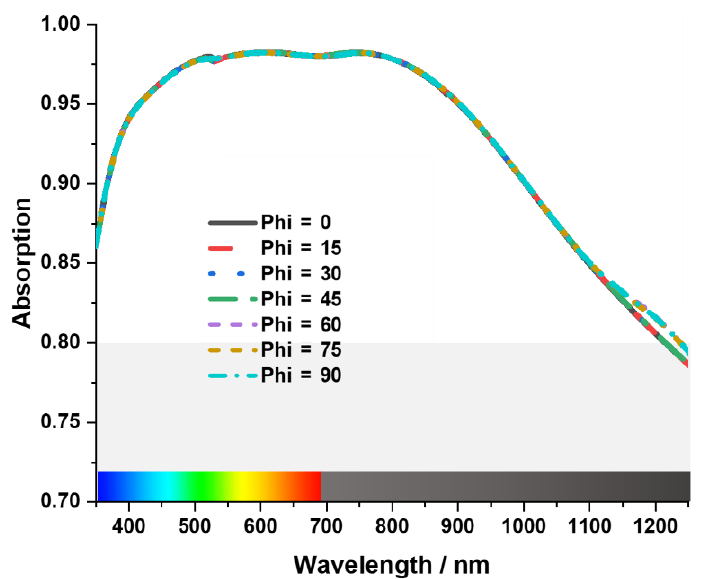
Figure 11. Illustration of the polarization independency of the MA.